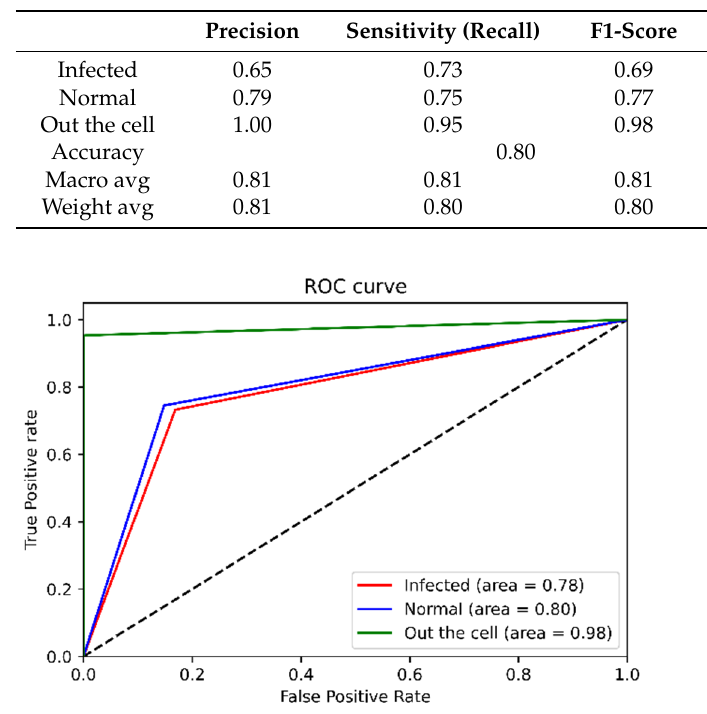
Figure 11. ROC curve of PCA-LDA model evaluation using blind sample data sets (test set) .